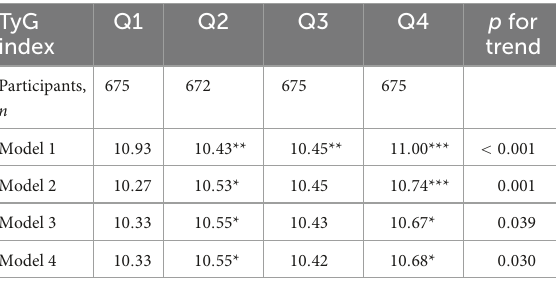
TABLE 1 Association between quartiles of TyG-index and c-f PWV ( n =